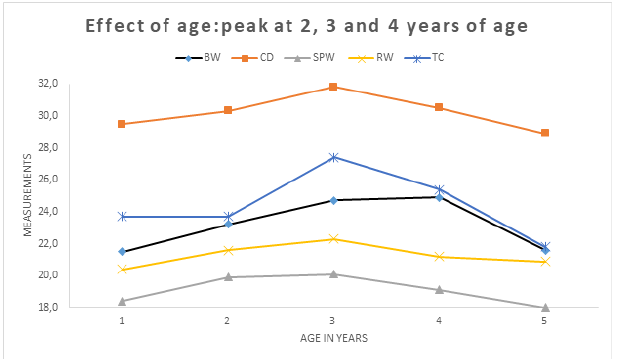
Figure 2. Effect of age on body weight(BW), chest depth (CD), shoulder point width (SPW), rump width (RW), and testis circumference (TC).